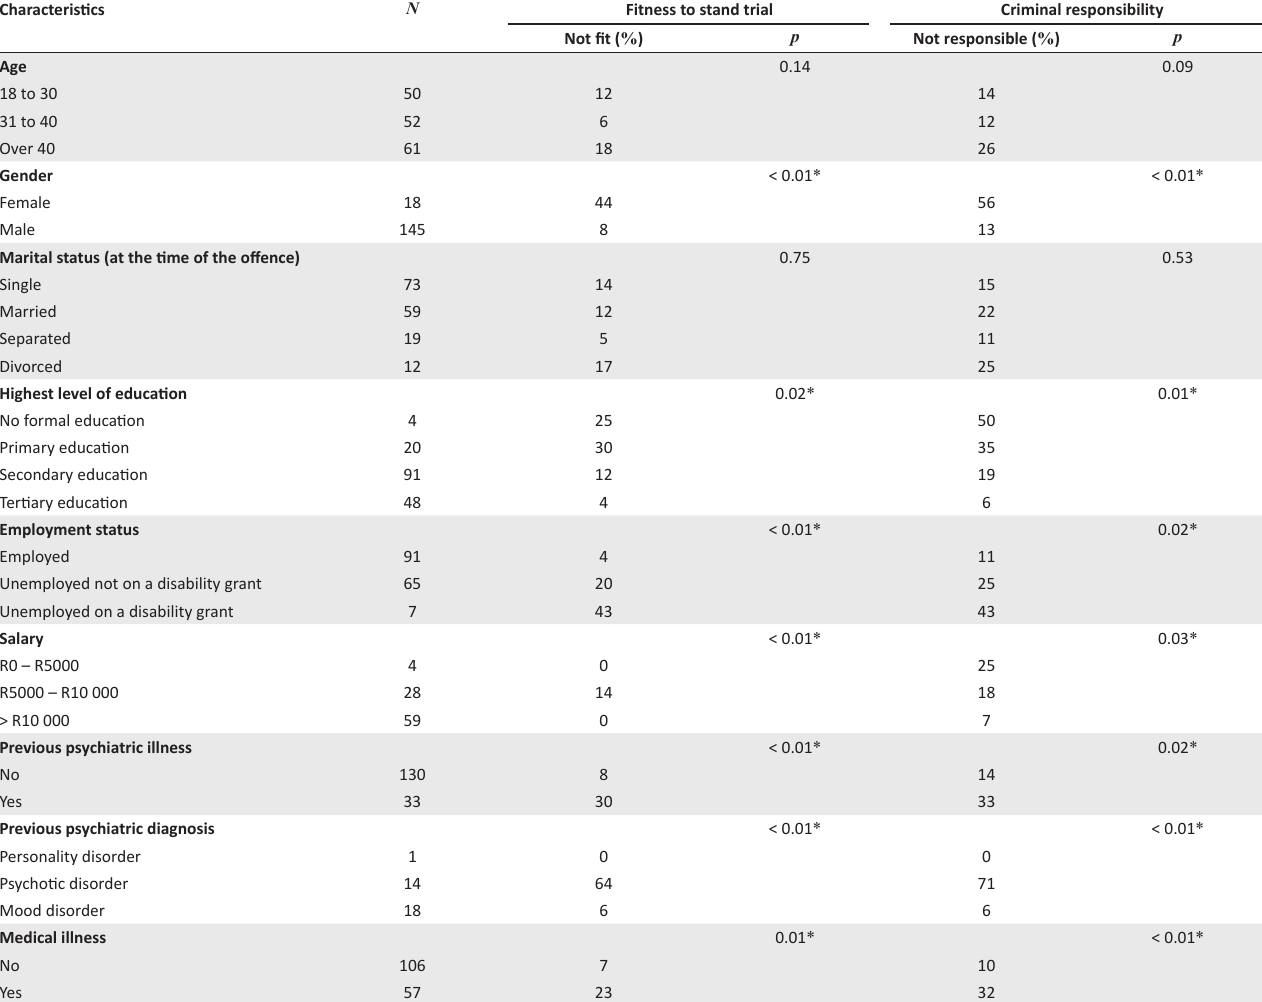
TABLE 4: Accused and offence characteristics and diagnosis according to the categories of psychiatric observation outcomes with p values.